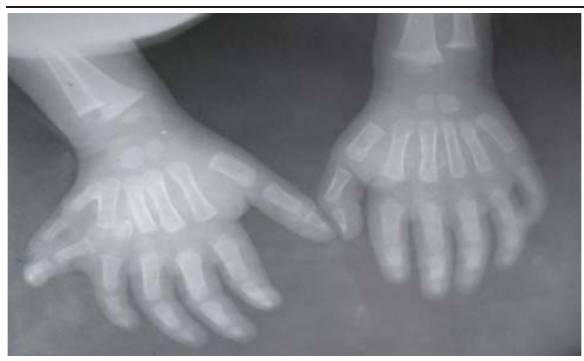
Figure 1. Radiograph of both hands showing 7 digits in right hand with well formed bifi d 6 th metacarpal. The left hand has well formed 6 th metacarpal and phalanges